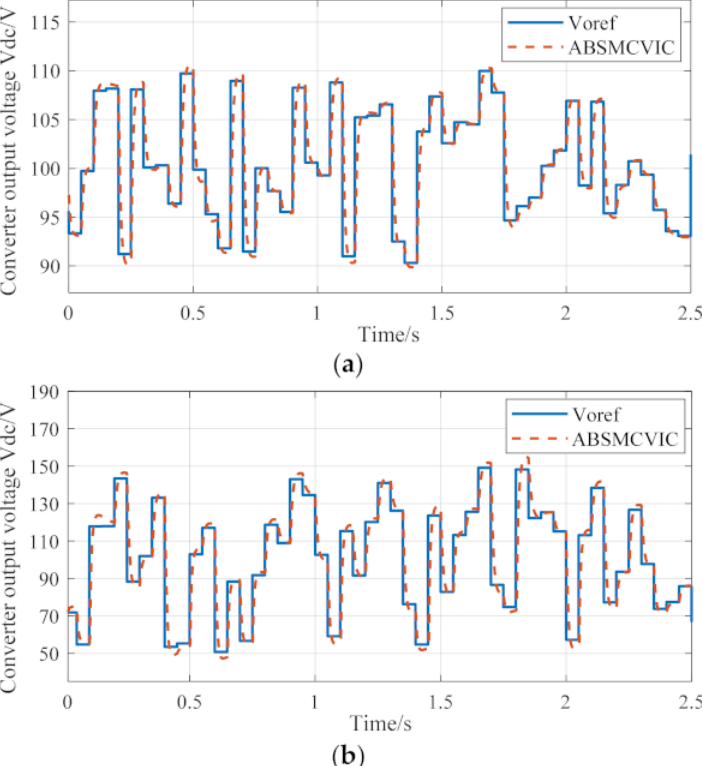
Figure 10. Output voltage response curves of converters under continuous dynamic changes. ( a ) Continuous dynamic change in a small range. ( b ) Continuous dynamic change in a large